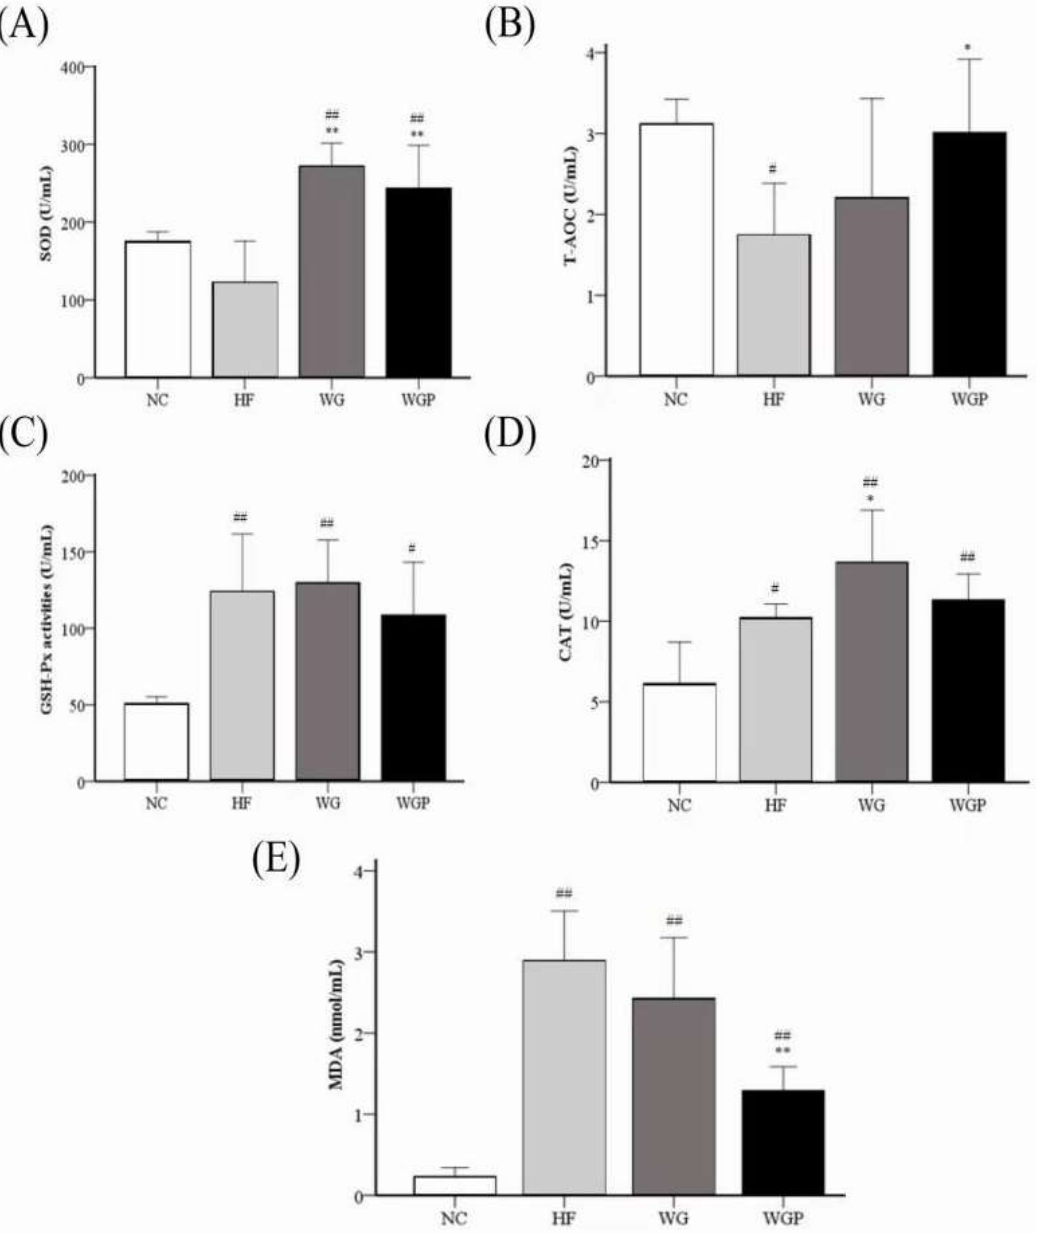
Figure 7. Effect of wheat germ and wheat germ protein on liver antioxidant status, SOD ( A ), T-AOC ( B ), GSH-Px ( C ), CAT ( D ) and MDA ( E ), in the high-fat diet-induced rats. Values are presented as means ± SEMs ( n = 5). # p < 0.05, ## p < 0.01 vs. NC group. * p < 0.05, ** p < 0.01 vs. HF group.